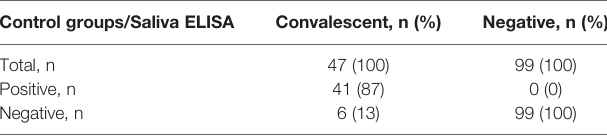
Chi²-test (two-tailed): p <